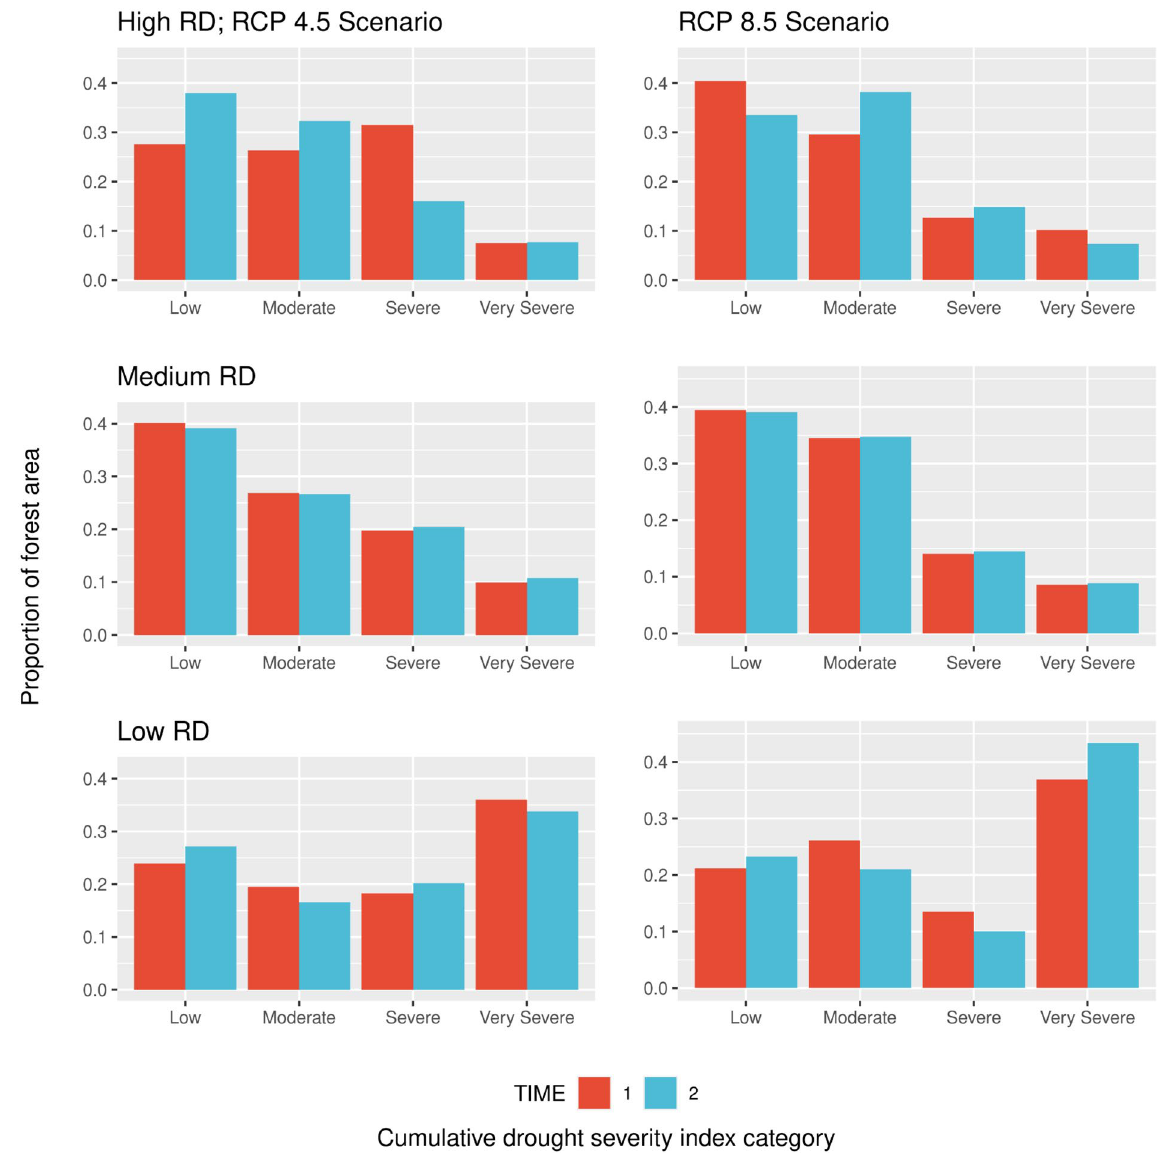
Figure 5. Proportion of coterminous US forest area by classes of live tree stocking (RD < 0.3 = low, 0.3 > RD < 0.6 = medium, RD > 0.6 = high) by classes of the projected cumulative drought severity index 31 for 2040–2069 based on two regional climate projections (RCP 4.5 and 8.5). Drought categories were based on quartiles of the observed data (< 25% = low; > 25% & < 50% = moderate; > 50% & < 75% = severe; > 75% = very